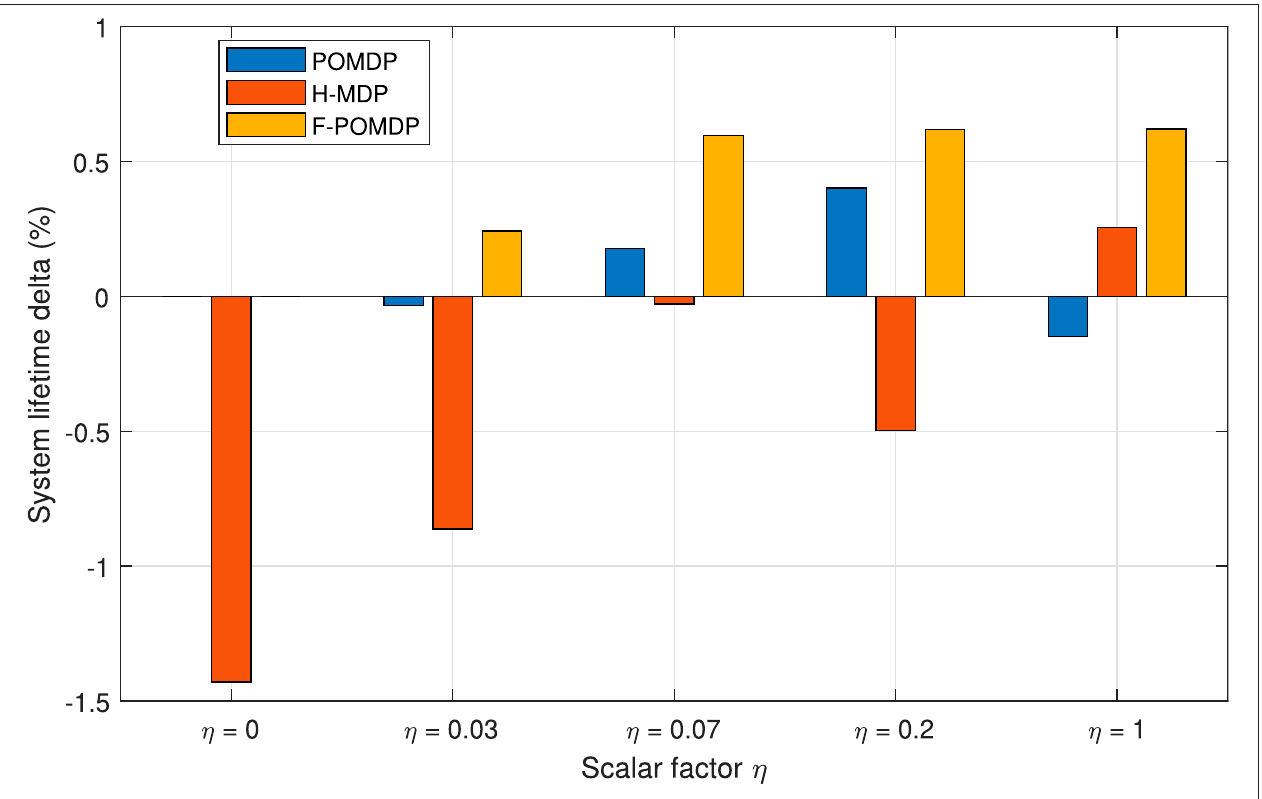
FIGURE 8 | Relative increase in the system lifetime Δ K (i.e., the time to reach one of the absorbing states with N consecutive errors) w.r.t. the fully observable, optimal policy of MDP.